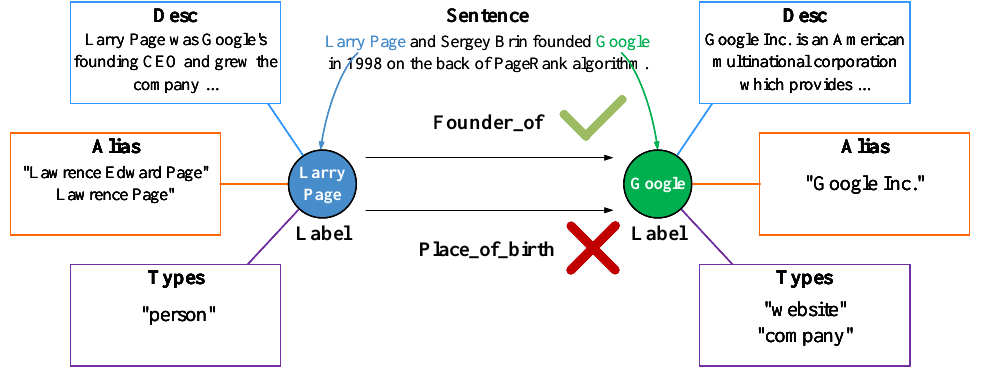
Figure 1. An example of entity attributes in the relation extraction